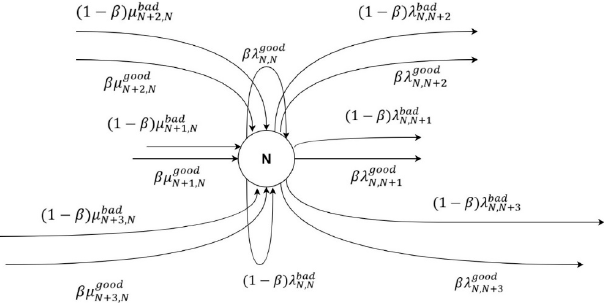
Figure 4. The Markov chain illustration for one state example.